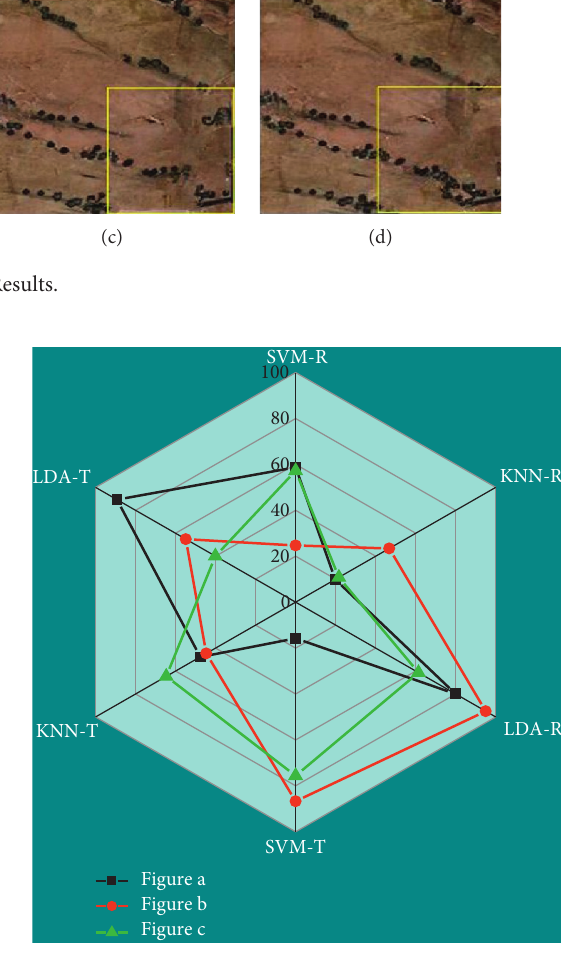
Figure 9: Comparison of PSNR values of restoration results by